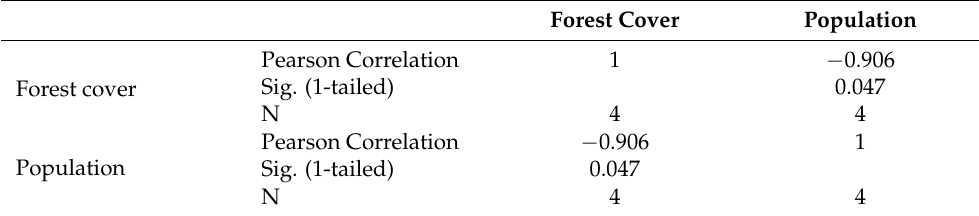
Table 3. Correlations between population density and forest cover change. Forest Cover Population Pearson Correlation 1 − 0.906 Sig. (1-tailed) 0.047 Forest cover N 4 4 Pearson Correlation − 0.906 1 Population Sig. (1-tailed) 0.047 N 4